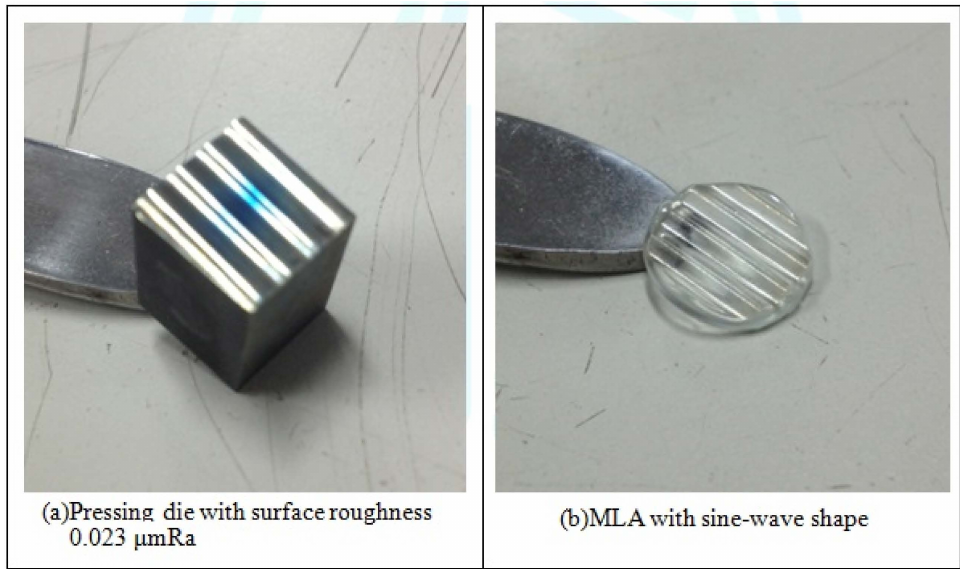
Figure 14. Pressing die with sine-wave shape (surface roughness 0.023 µ m Ra) and MLA produced using this